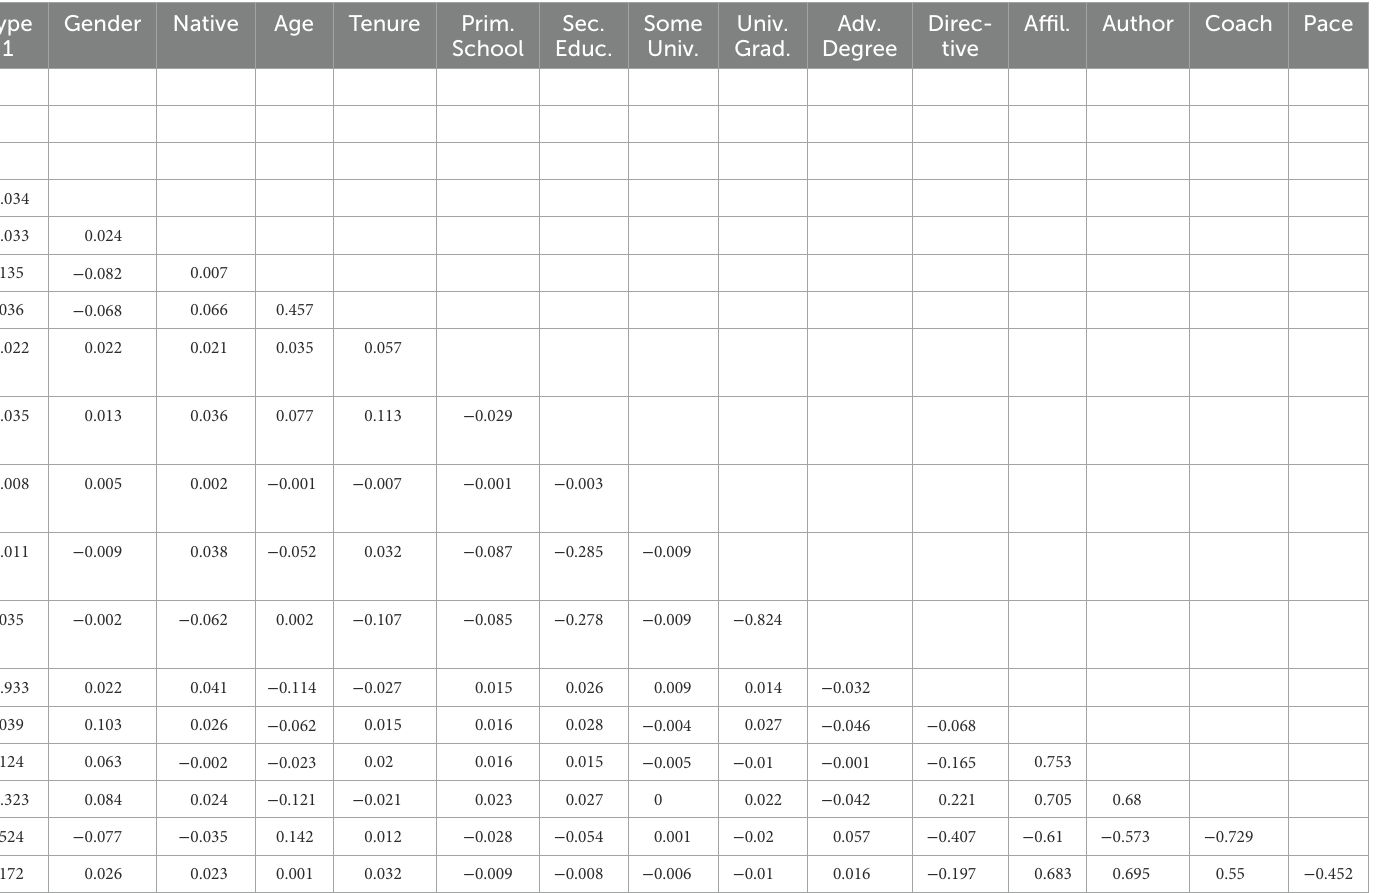
TABLE 3 Correlations between three archetypes, six leadership styles, and